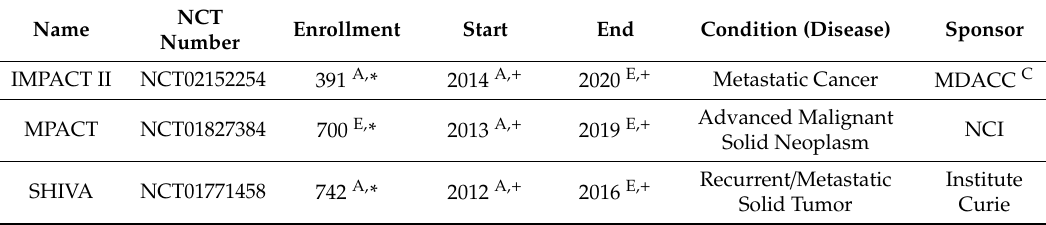
Table 2. Summary of randomized histology-agnostic studies examined in this article. Data extracted from clinicaltrials.gov (October, 2018).